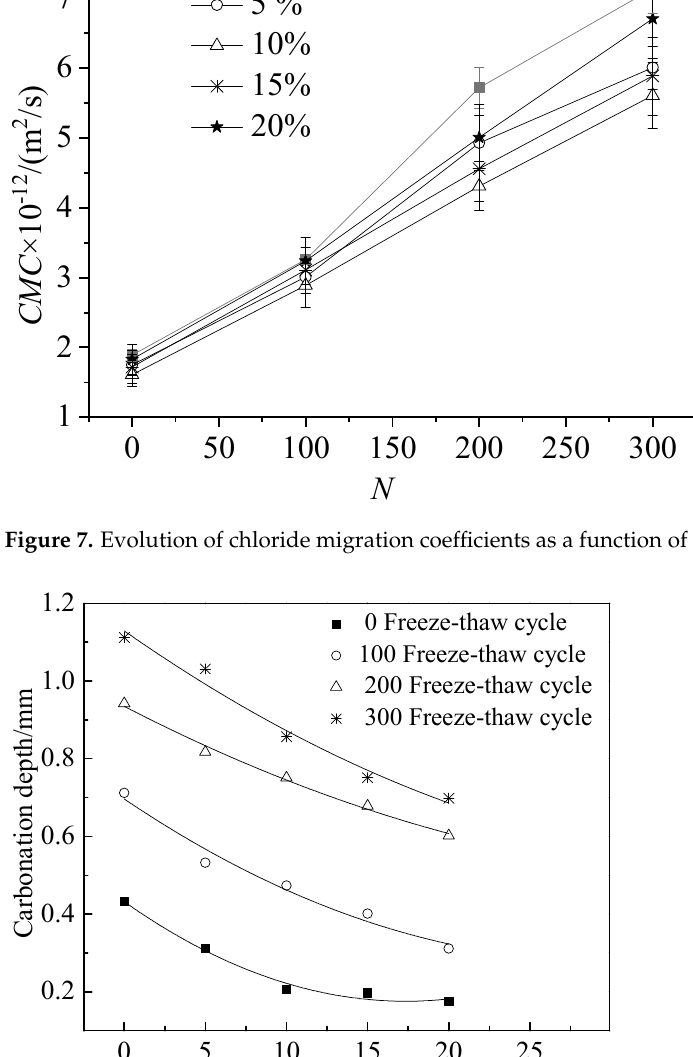
Figure 8. Carbonation depth of RPC with WFA at different NaCl freeze–thaw cycles.